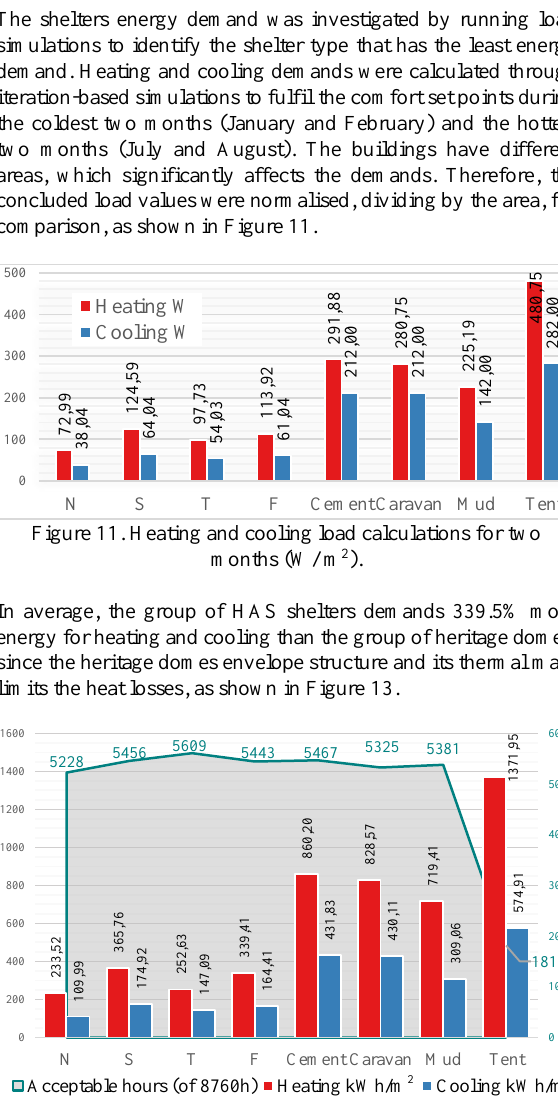
Figure 12. Energy consumption pared with delivered comfort for one year.